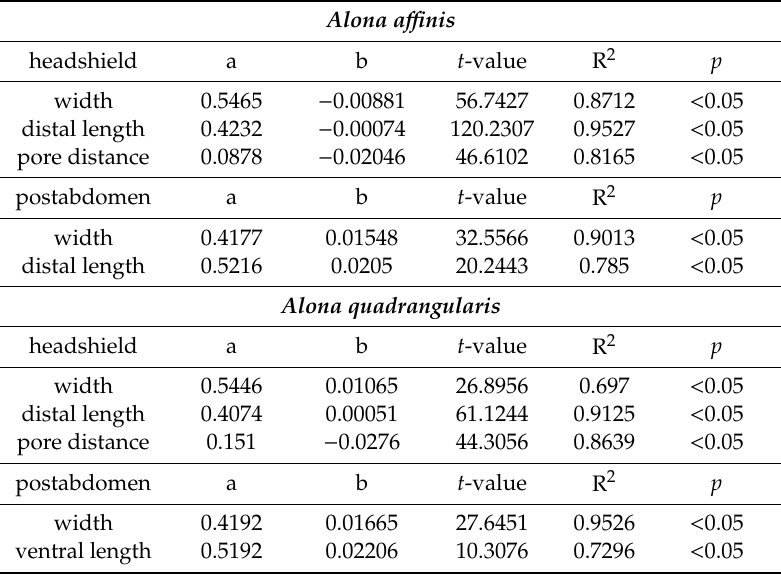
Table A1. Coe ffi cients of linear regressions ( y = ax + b ) of headshields and postabdomen measurements of Alona a ffi nis and A. quadrangularis